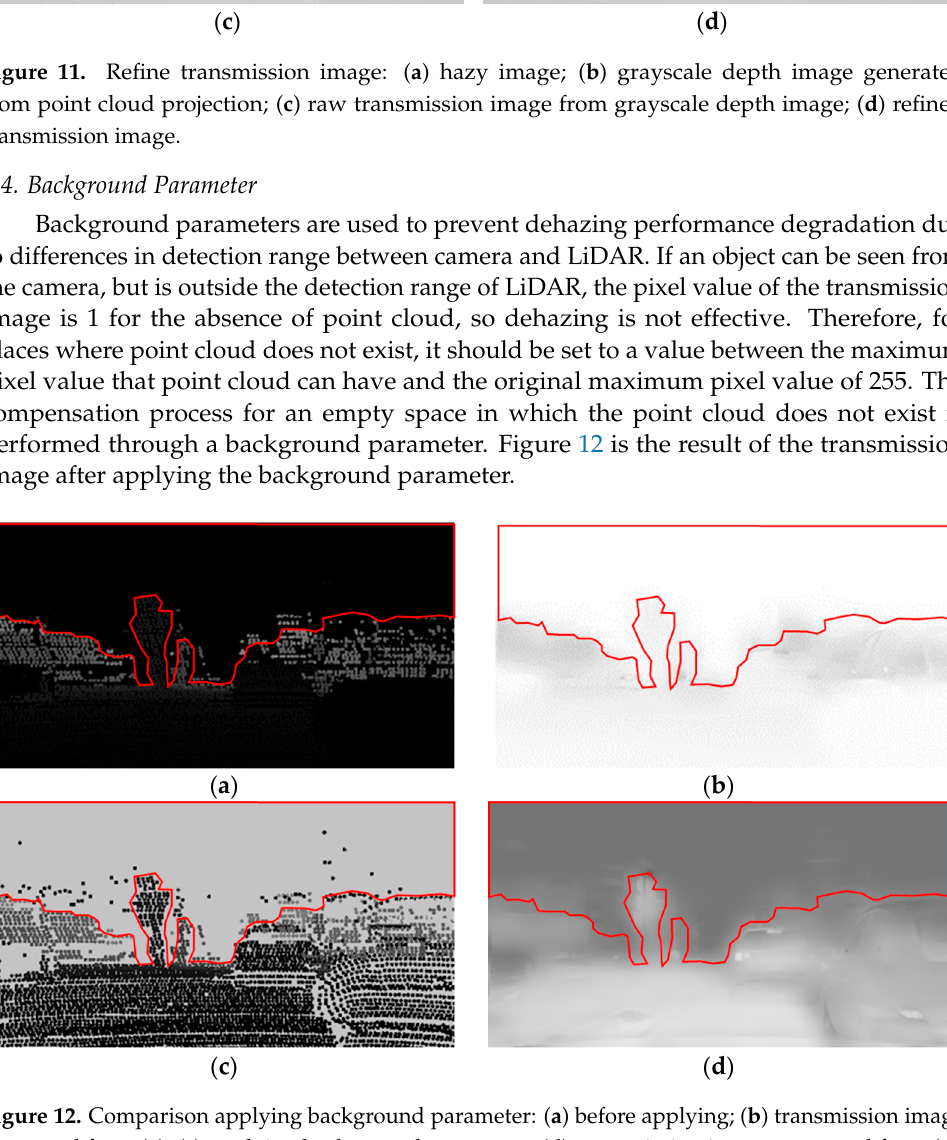
generated from ( a ); ( c ) applying background parameter; ( d ) transmission image generated from ( c ).